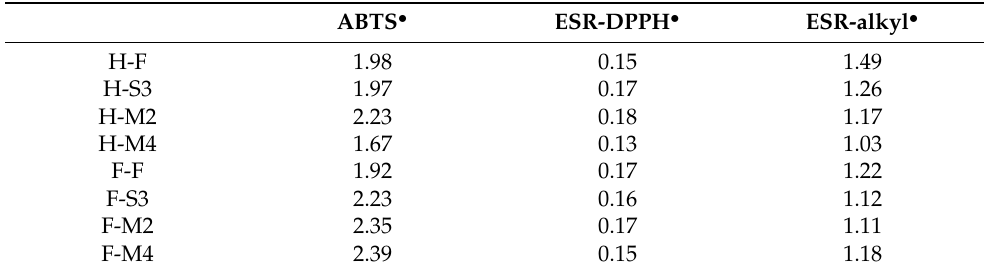
Table 1. EC 50 (mg/mL) values obtained from various antioxidant assays for broccoli extracts